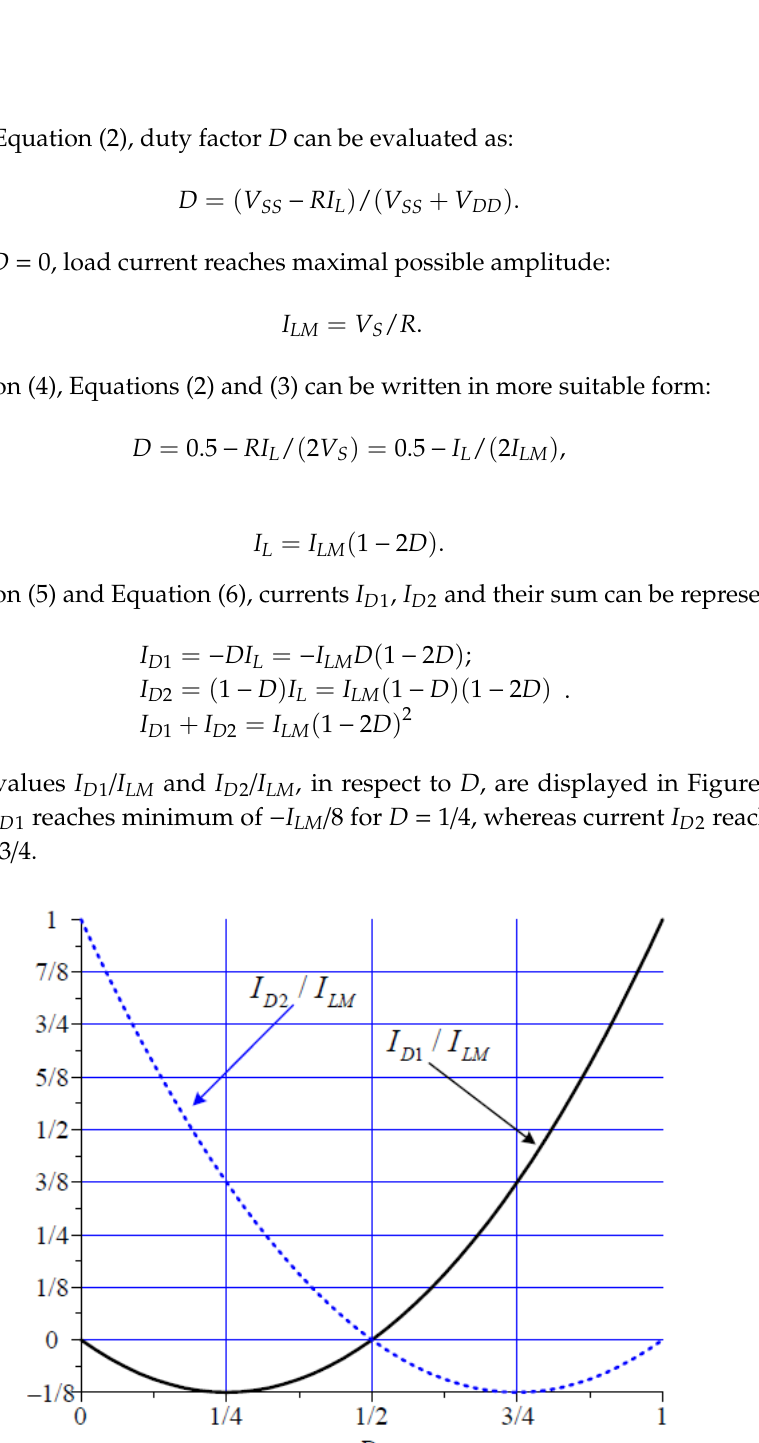
Figure 2. Normalized values I D 1 / I LM and I D 2 / I LM with respect to D .